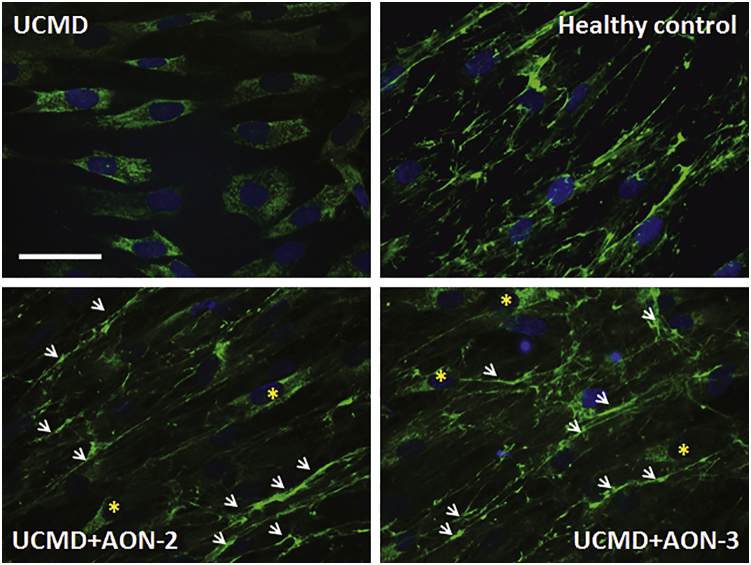
Gapmer AON Decreased Intracellular Collagen VI Retention and Increased Its ECM Deposition in FibroblastsThe fibroblasts were permeabilized by 0.1% Triton in blocking buffer during immunostaining. Strong intracellular accumulation was observed in patient’s untreated fibroblasts (UCMD) compared to healthy control fibroblasts, where collagen VI was localized in the ECM. After a single treatment of AON-2 (UCMD+AON-2) or AON-3 (UCMD+AON-3) at 20 nM, the retention of intracellular collagen VI was markedly reduced, although it was notable occasionally in some cells (asterisk) and accompanied by partial deposition in the ECM (arrow).